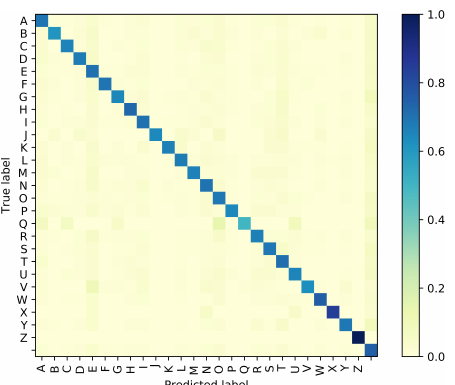
Figure 7. Confusion Matrix for Attention-based